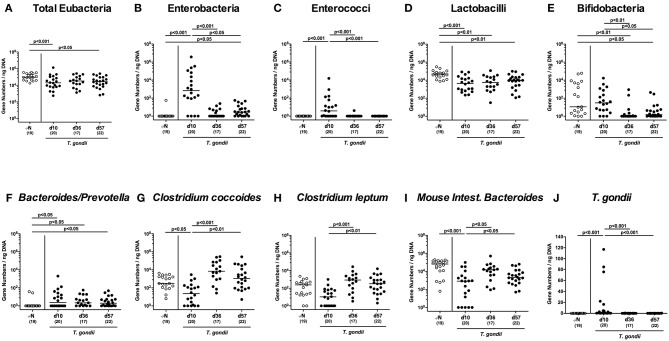
Ileal microbiota composition and parasitic loads over time following peroral low-dose T. gondii infection. Mice were perorally infected with one cyst of T. gondii on day 0 and surveyed at days (d) 10, 36, and 57 post-infection (p.i.; closed circles). Naive (N) mice served as uninfected controls (open circles). (A) The total eubacterial loads as well as the main gut bacterial groups (B–I, as indicated) and (J)
T. gondii DNA were quantitated in ileal samples by culture-independent molecular methods and expressed as gene numbers per ng DNA. Medians (black bars), levels of significance (p-values) as determined by one-way ANOVA test followed by Tukey post-correction for multiple comparisons and numbers of analyzed mice (in parentheses) are indicated. Data were pooled from four independent experiments.